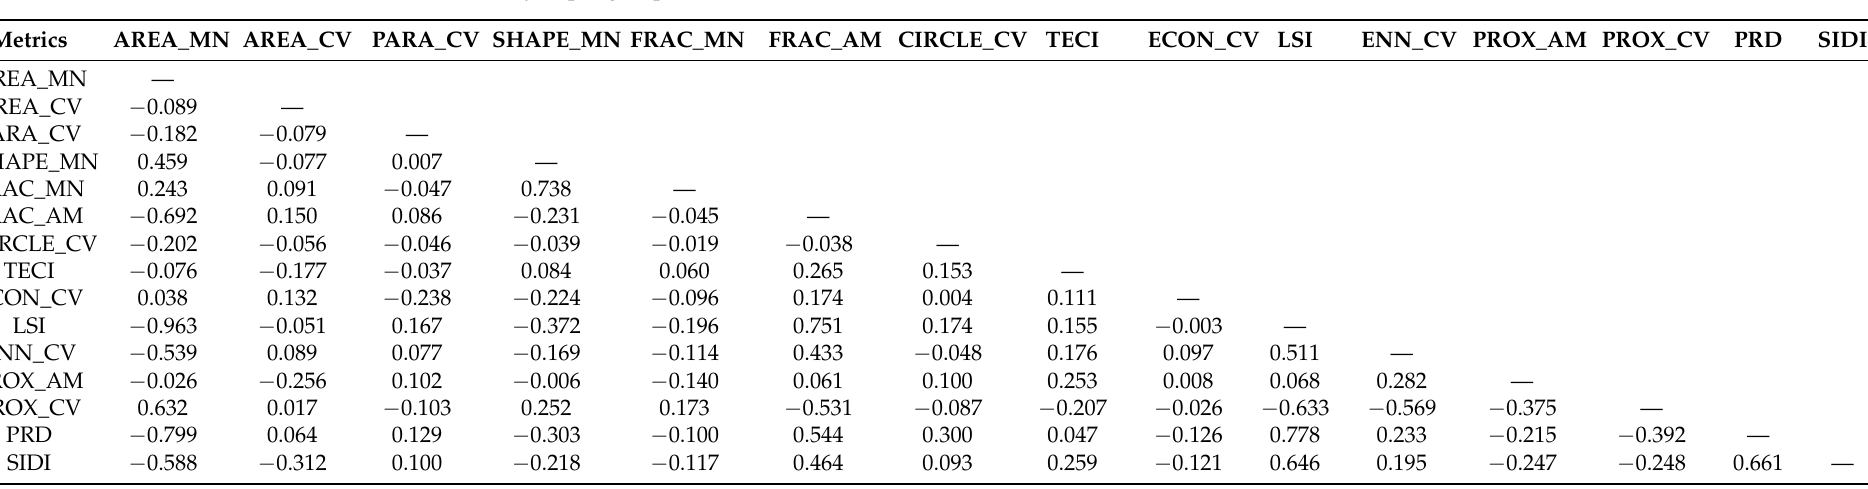
Table A2. Overall Spearman correlation analysis for the 500 ha hexagon grid, including the 15 metrics, respectively, determined as representatives for the retained factors of the factor analysis per